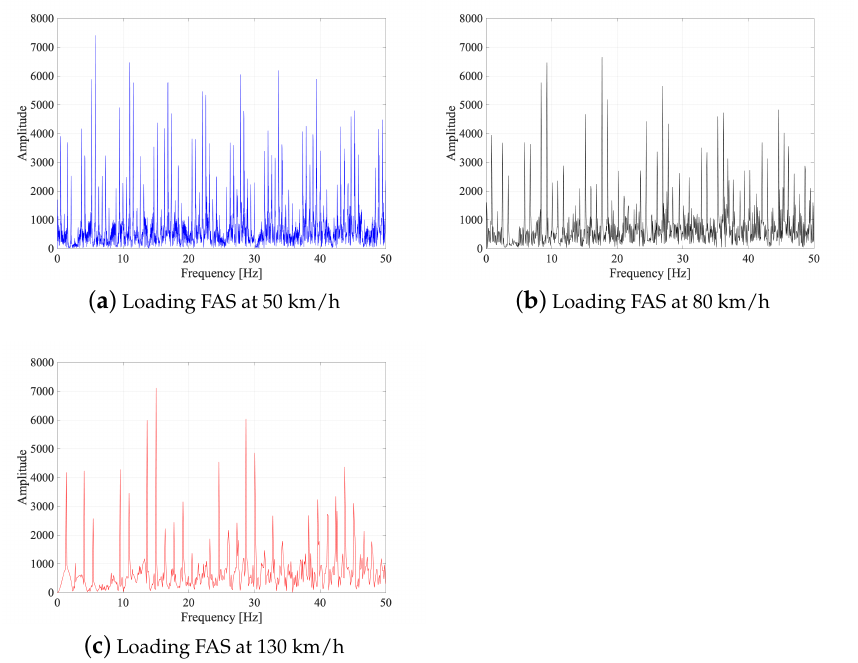
Figure 6. Fourier amplitude spectrums for the loading for ICE-2 train at different